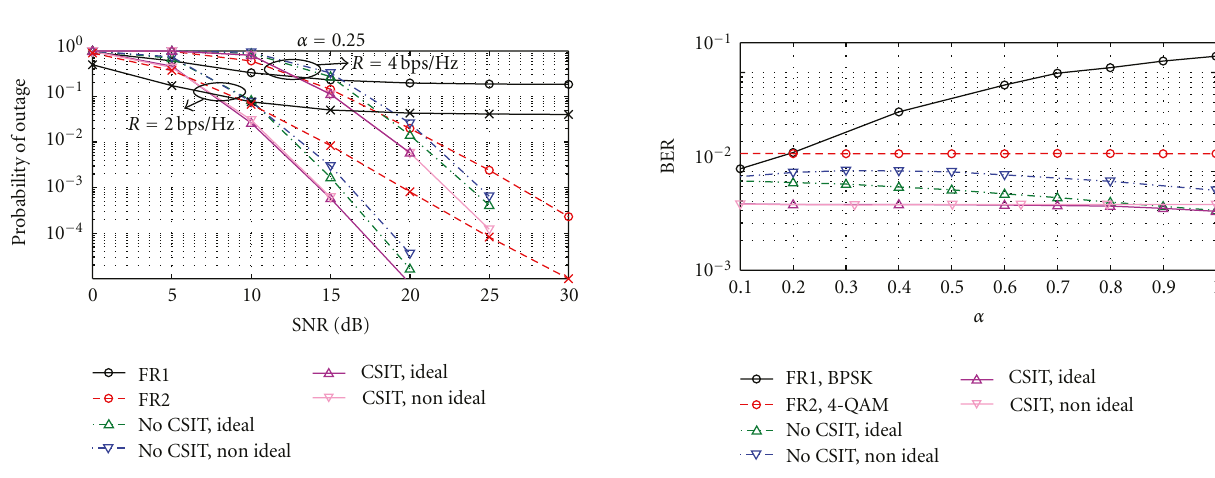
Figure 6: The joint probability of outage of M 0 and M 1 , as a function of the SNR (dB), for two isolated base stations and two target spectral e ffi ciencies ( R = 2 bps/Hz and = 4 bps/Hz), for both the FR1 and the FR2 scenarios. The link quality is α = 0 . 25. The non ideal link denotes the case when the base station-to-base stationlink gain is β = α .